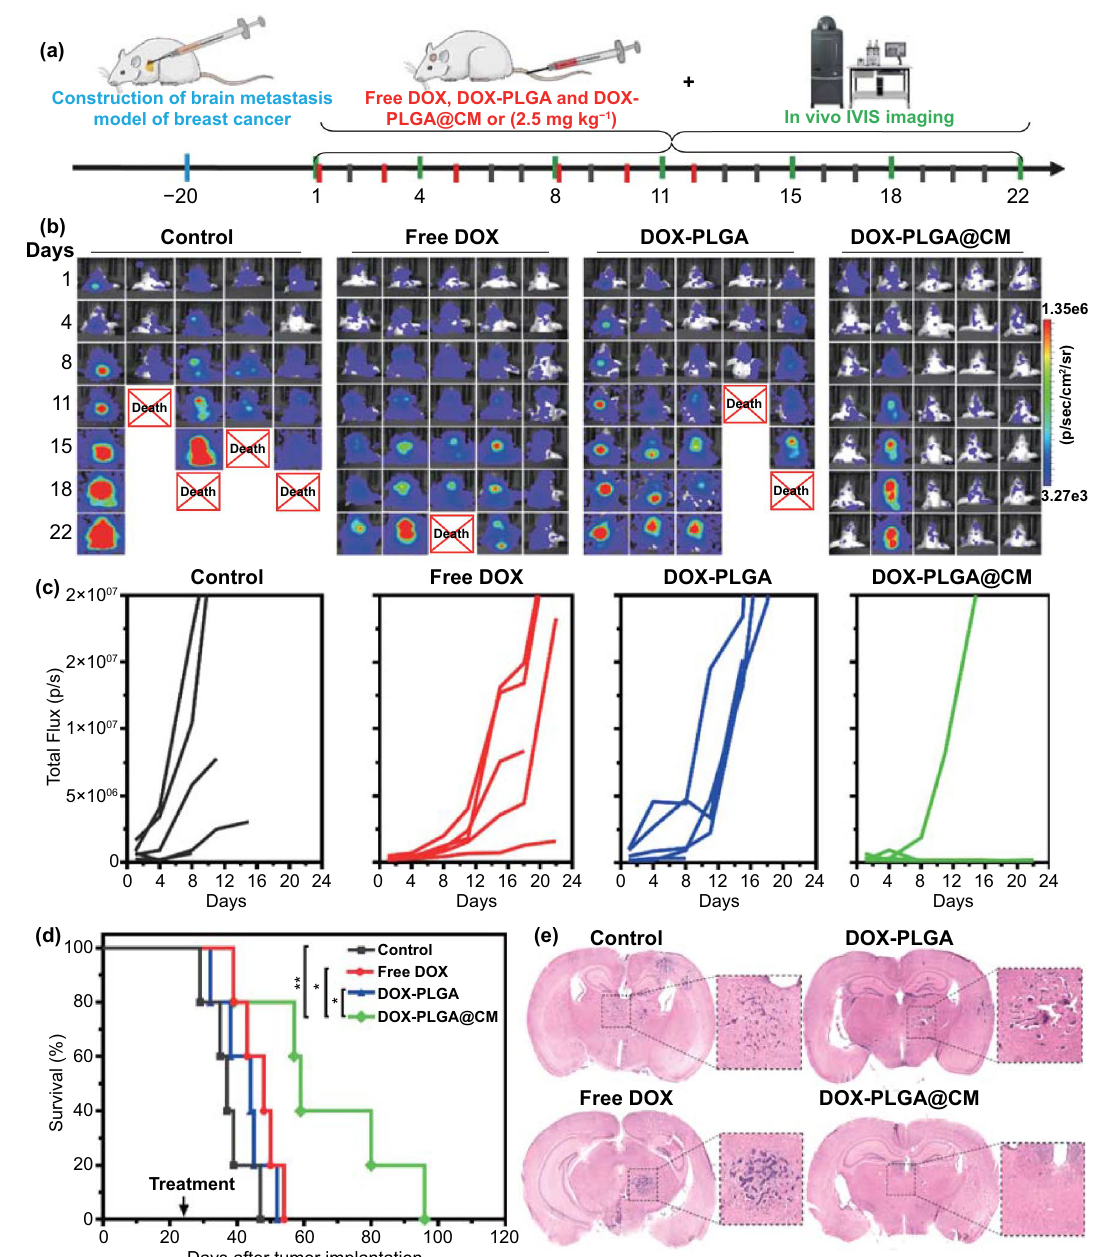
Fig. 5 In vivo anticancer efficacy of DOX‑PLGA@CM in brain metastases of breast cancer model. a The schedule of treatment regimen. b In vivo bioluminescence imaging of brain metastases of breast cancer at indicated time. c Quantitative bioluminescence intensity of cancer brain metastases corresponding to panel ( b ). d Kaplan–Meier survival curves of brain metastases mice received the indicated treatments. n = 5. e Rep‑ resentative whole brain H&E staining of brain isolated from mice received the indicated treatments. * p < 0.05, ** p <